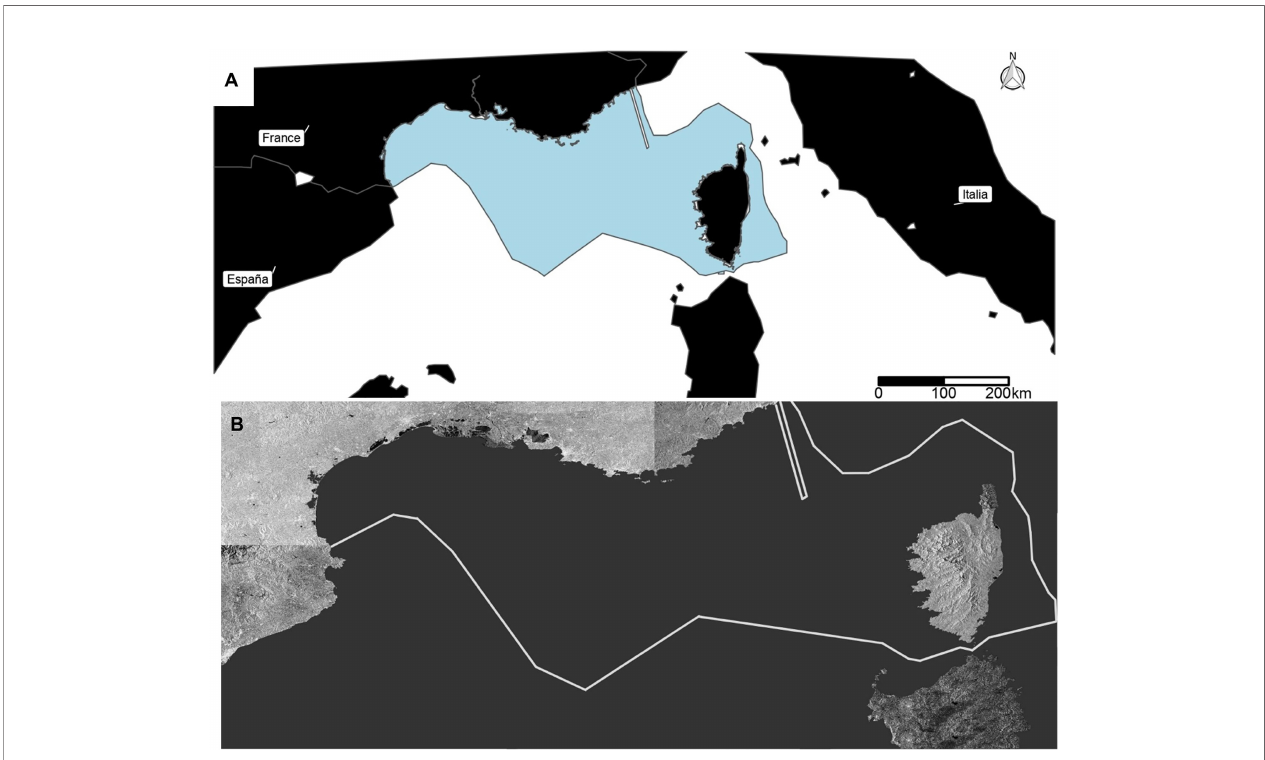
FIGURE 1 | (A) Plot depicting the French Mediterranean Exclusive Economic Zone (EEZ) and study area, represented in blue. (B) Study area built with several SAR images captured between 6 th and 18 th of March 2020. In white lines, the French Mediterranean EEZ. Shapes are different due to the angle from which the images are taken by the satellites. Copernicus Sentinel data